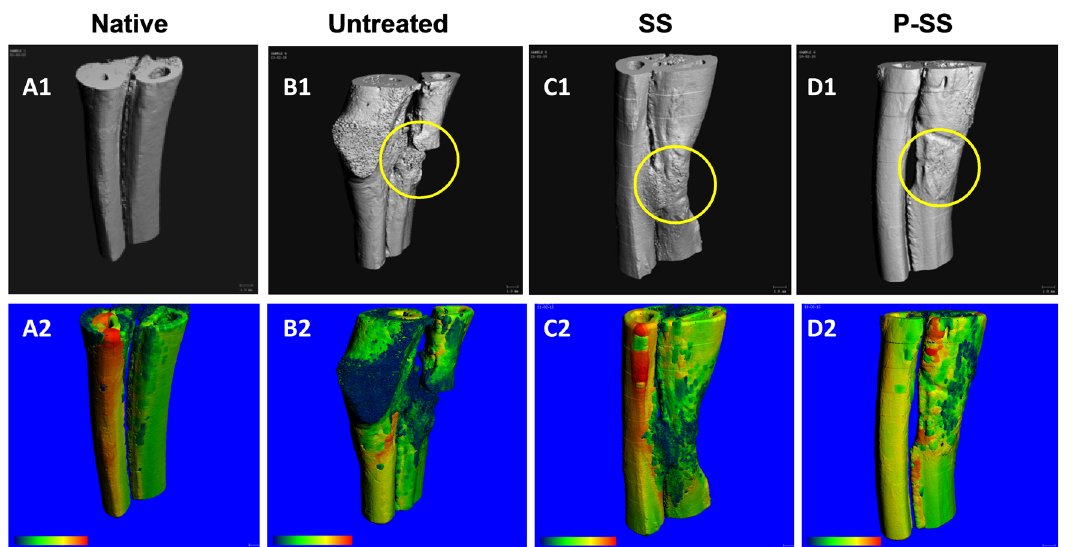
Fig. 6 Micro-CT analysis of ( A ) native, ( B ) Control and implanted groups ( C ) SS and ( D ) P-SS after 12 weeks of